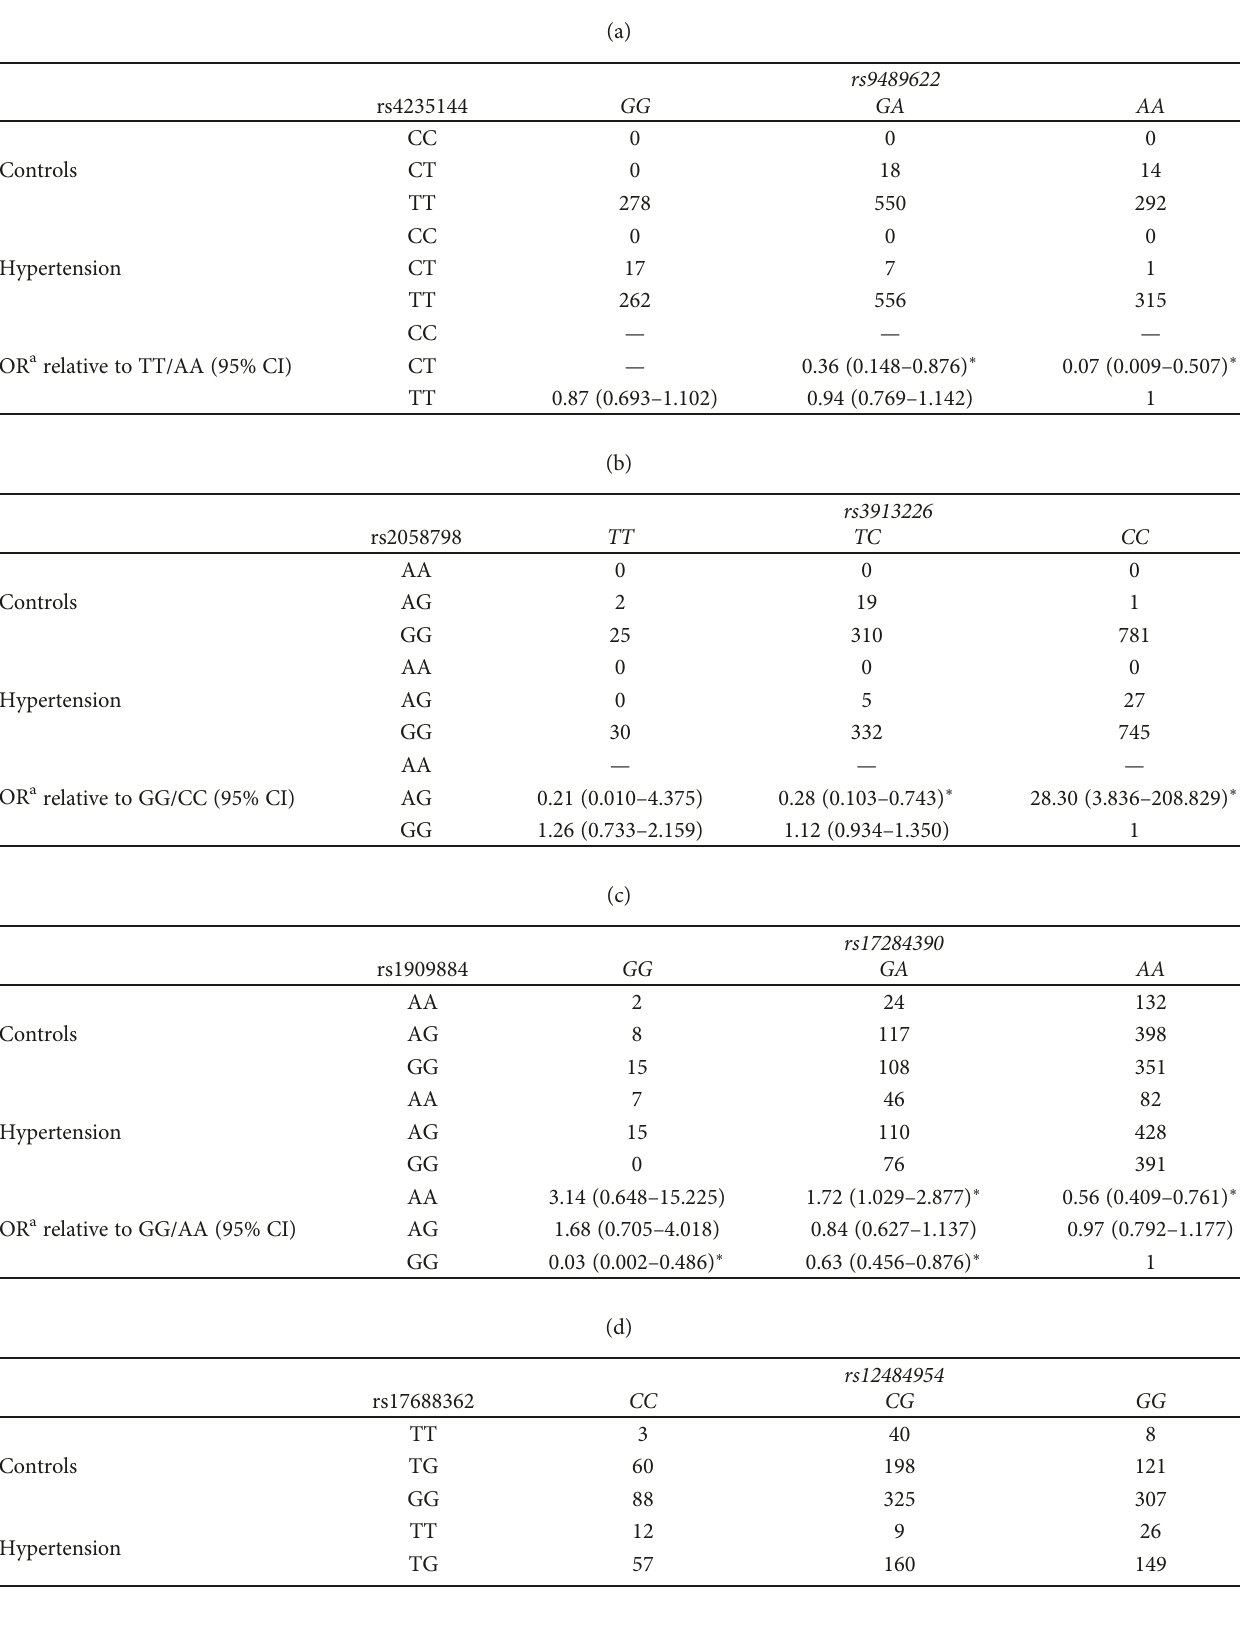
Table 2: Genotype counts for SNP pairs and odds ratios relative to the double major allele homozygote genotype in the o ff spring